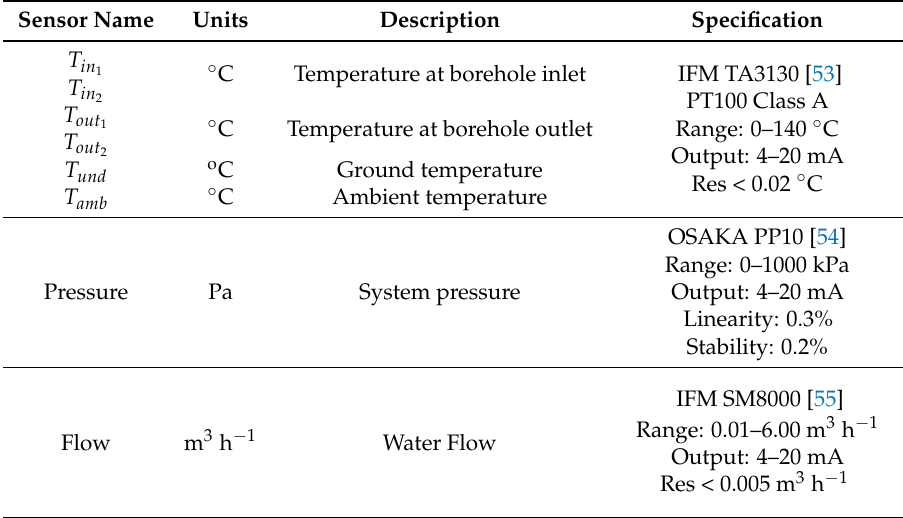
Table 1. List of the sensors and their main